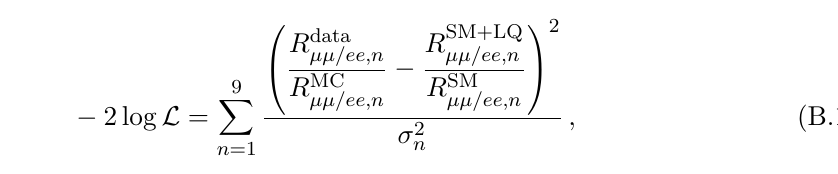
in the nine di-lepton mass bins. We show the distributions µµ/ee = 1 . 0 and/or Y RL = 1 . 0 1 e 1 e